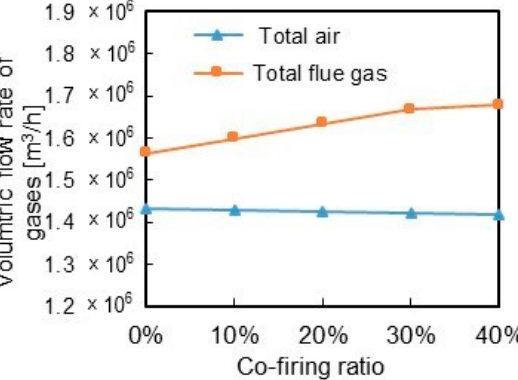
Figure 2. Volumetric flow rates of combustion air and flue gas.